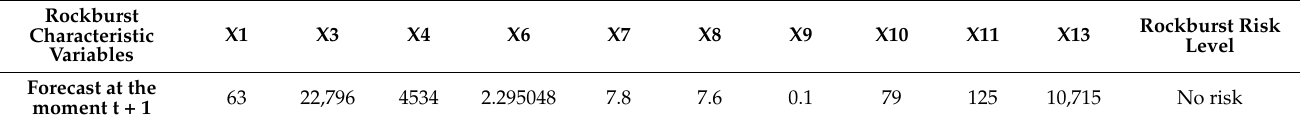
Table 5. Rockburst risk level prediction at time t + 1.